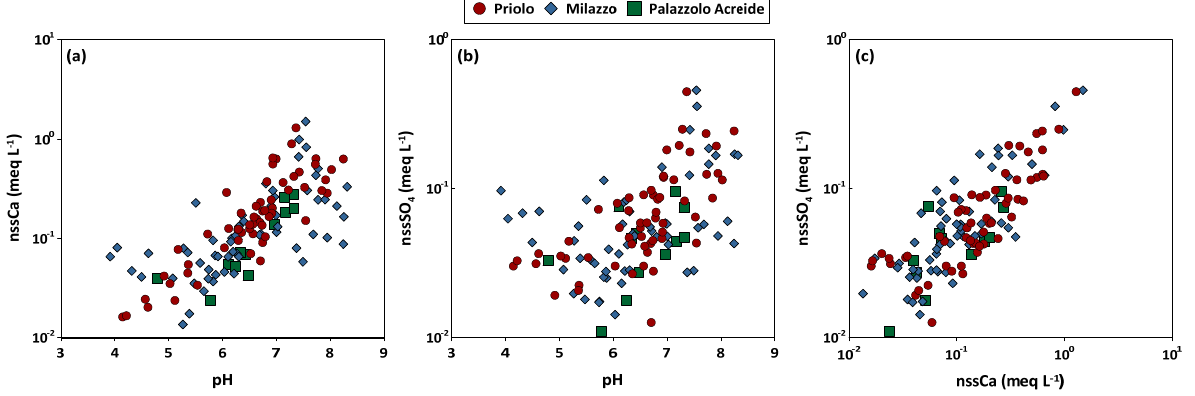
Figure 6. Correlation between pH values and nssCa 2+ (meq L − 1 ) ( a ), pH and nnsSO 42 − (meq L − 1 ) ( b ), and between nssCa 2+ (meq L − 1 ) and nnsSO 42 − (meq L − 1 ) ( c ), in all study areas.